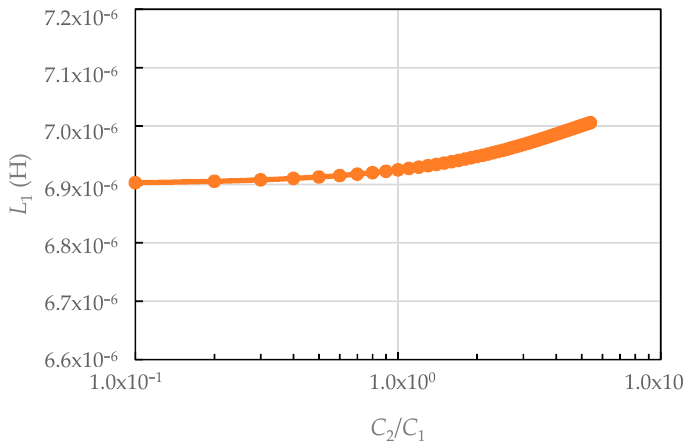
Figure 11. Inductor value L 1 for various ratios of the shielded capacitance C 2 / C 1 .